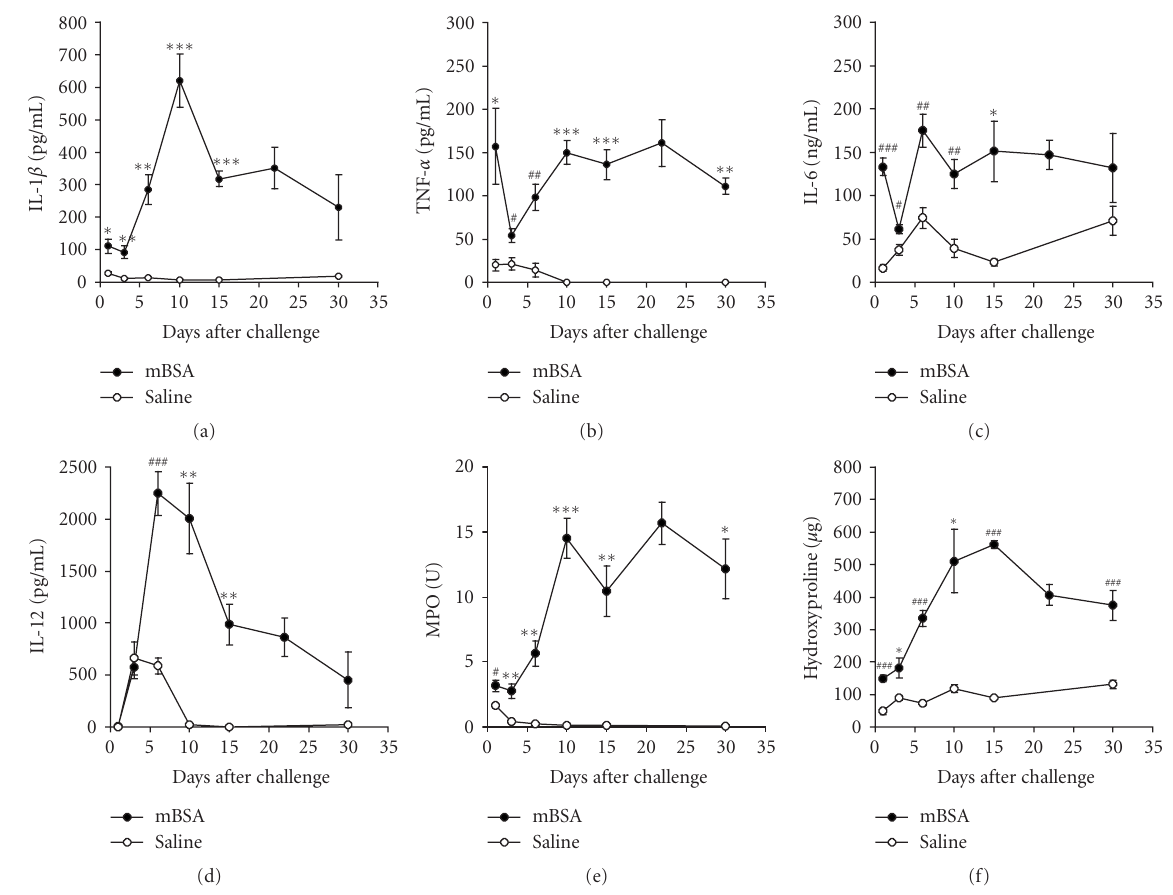
Figure 1: Time course of cytokine productions, myeloperoxidase (MPO) activity, and hydroxyproline content in the mBSA-induced granu- lomatous tissue. Mice sensitized with mBSA were challenged by subcutaneous implantation of a membrane filter soaked in mBSA solution in the back of the mice on day 0. Granuloma was collected on the indicated days and cultured in vitro for 24 hr. Cytokines were measured in the supernatants. MPO activity and hydroxyproline content were measured in a mixture of the culture medium and the granuloma. IL-1 β (a), TNF- α (b), IL-6 (c), IL-12 (d), MPO activity (e), and hydroxyproline content (f). Results are shown as the mean ± SE of 4 to 6 mice. #: P < . 05, ##: P < . 01, ###: P < . 001 (The Student’s t test), ∗ P < . 05, ∗∗ P < . 01, ∗∗∗ P < . 001 (Aspin-Welch test). Representative data from three independent experiments are